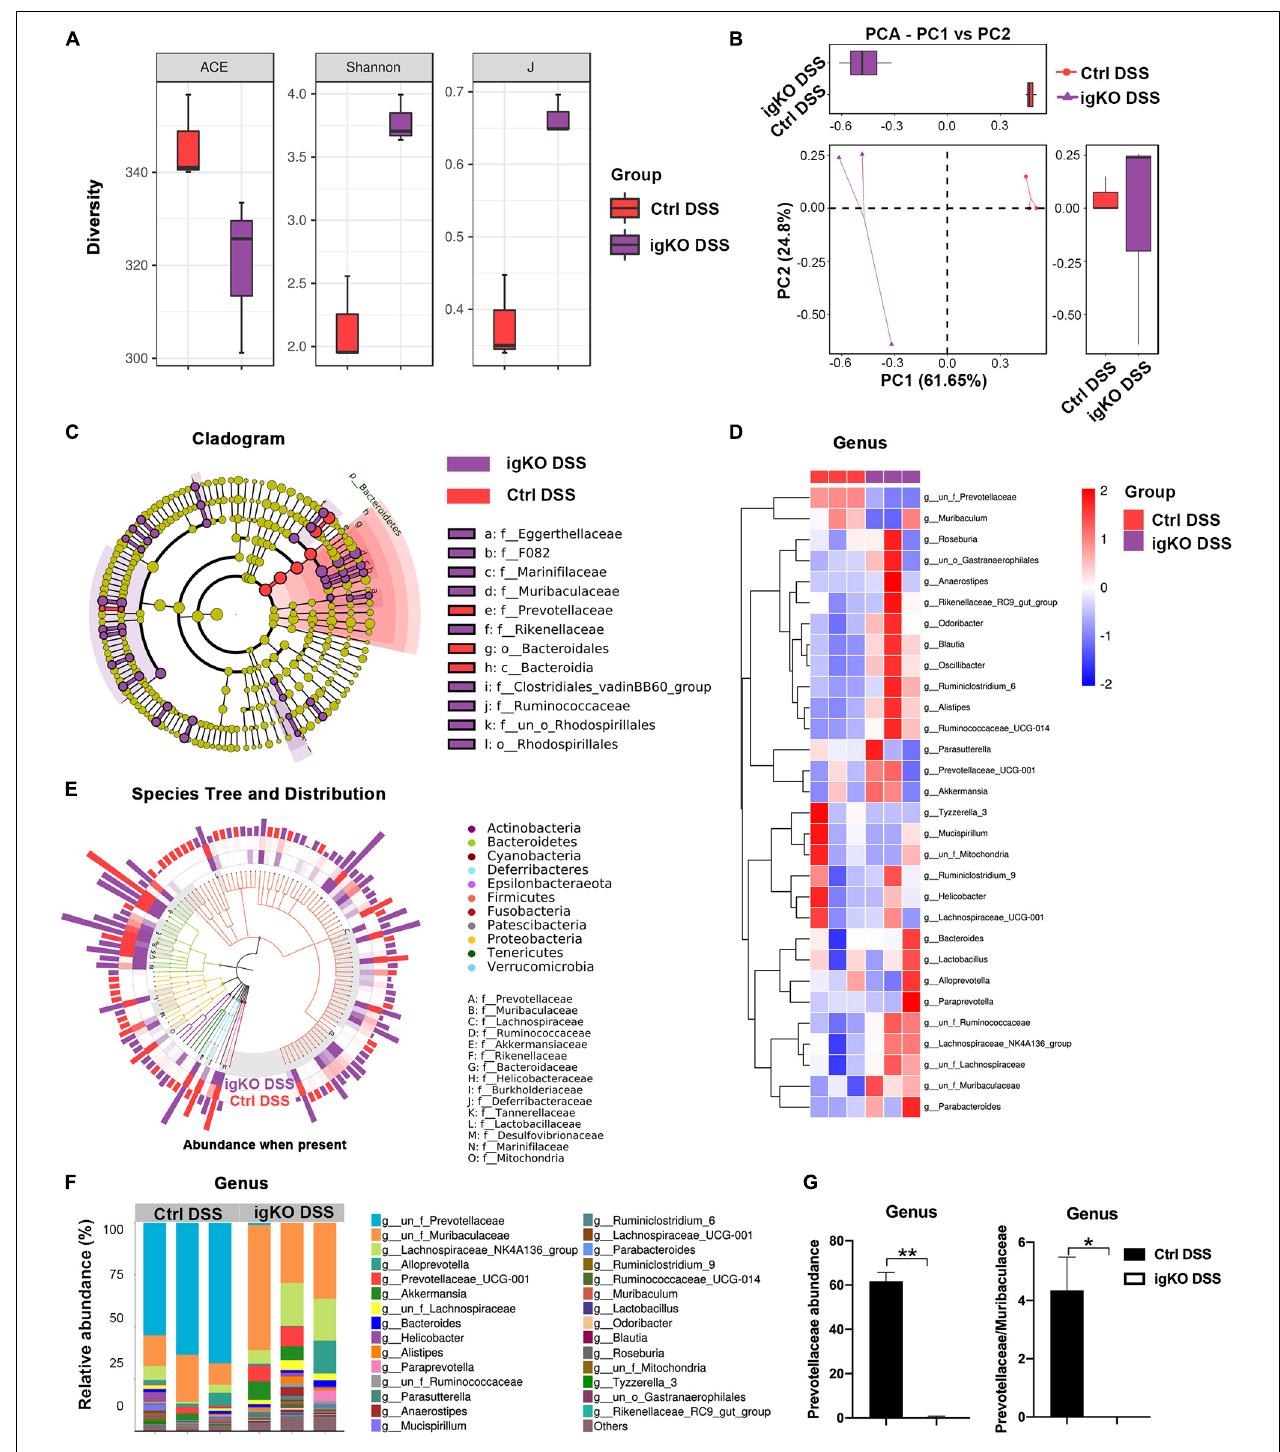
FIGURE 2 | Dysbiosis of gut microbiota in colitic Rgmb-deficient mice. (A) Rgmb-deficiency altered α -diversity of gut microbiota in mice with colitis. (B) OTUs indicate significant compositional discriminations of fecal microbiota by PCA between Rgmb-deficient and control colitis mice. (C) The cladogram of evolution relationship between gut microbiota from Rgmb-deficient and control mice with colitis. (D) Heatmap represents the relative abundance of gut microbiota from Rgmb-deficient and control mice with colitis at genus level. (E) The species tree and distribution of gut bacterium at species level in Rgmb-deficient and control mice with colitis. (F) The relative abundance of gut microbiota in Rgmb-deficient and control mice with colitis at genus level. (G) The relative abundance of Prevotellaceae (left panel) and the ratio of Prevotellaceae to Muribaculaceae (right panel) in Rgmb-deficient and corresponding control mice with colitis at genus level. n = 3. Each fresh fecal sample was pooled from five littermate mice. ∗ P < 0.05 and ∗∗ P < 0.01.